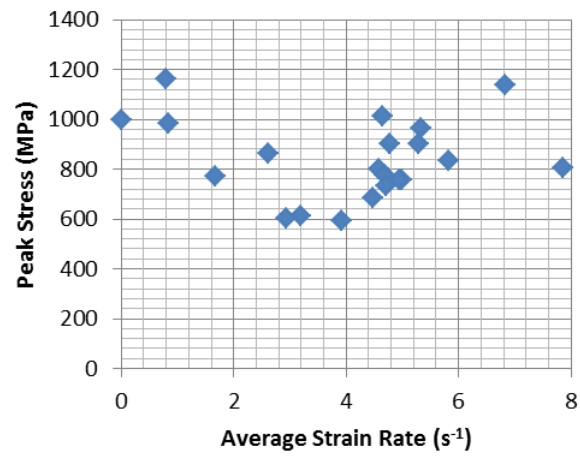
Figure 7. Peak stress vs . average strain rate for all